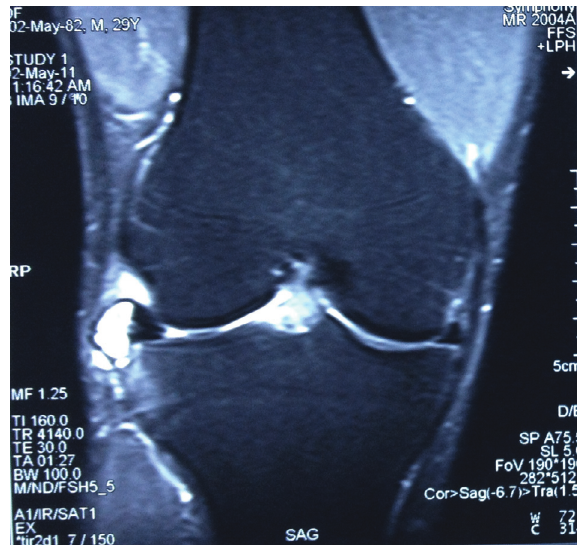
Figure 2. Perimeniscal cyst is seen on the middle horn of lateral meniscus of right knee. Horizontal tear, which extends along the entire meniscus, is seen on the preoperative coronal MR